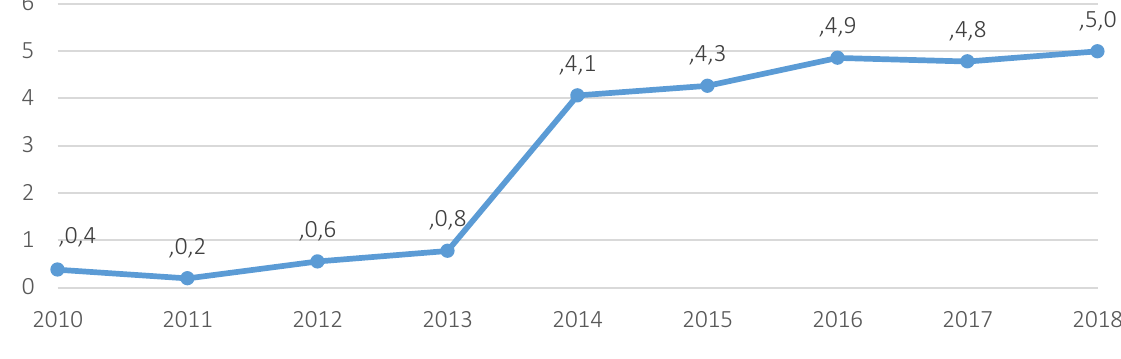
Figure 11. 4th class waste accumulation in Odesa region in 2010–2018, tons per person